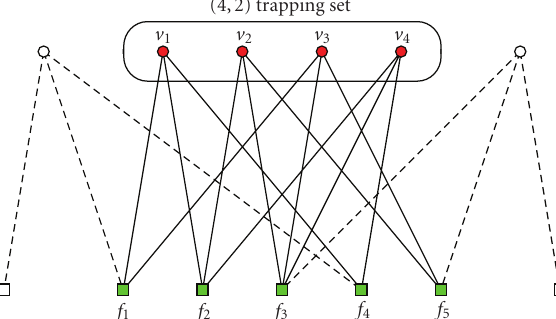
Figure 3: Example of a (4,2) trapping set in the Tanner graph of an LDPC